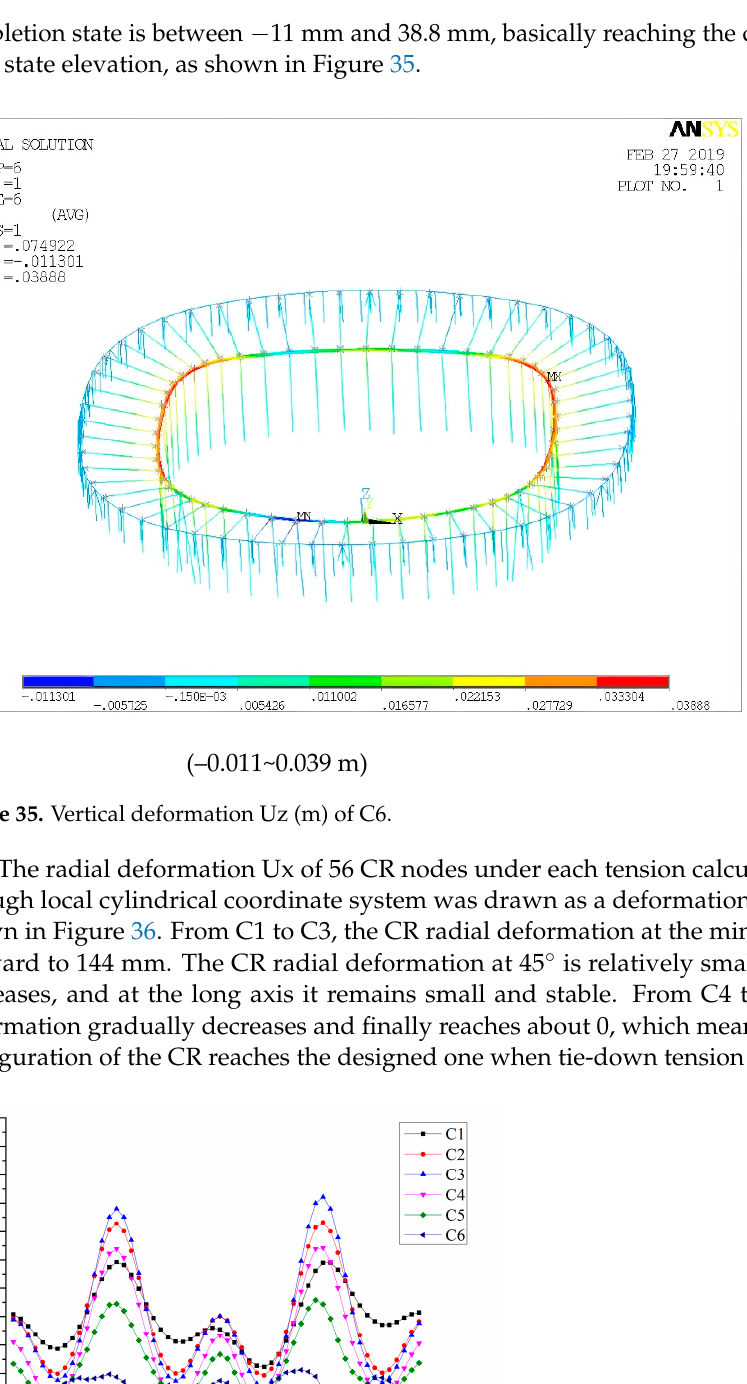
Calculation Conditions NO. Figure 37. Maximum equivalent stress curve of CR. Nephograms of tie-down forces under each calculation condition are shown in Fig- ure 38, which indicate that the tie-down force at the short axis is largest, followed by the long axis, and the cable force at the quarter is relatively the smallest. When the pull-down is completed, the cable force of the tie-downs reaches a maximum value of 547.6 kN.